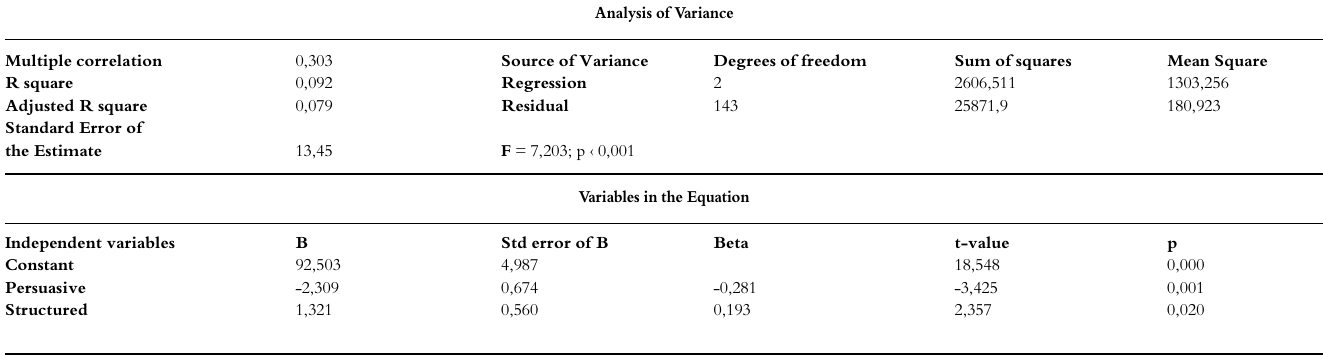
REGRESSIONOF PERSONALITYANDVERBALREASONINGABILITYON FACTOR III ^ DEPENDABILITY (DEPENDENT VARIABLES)